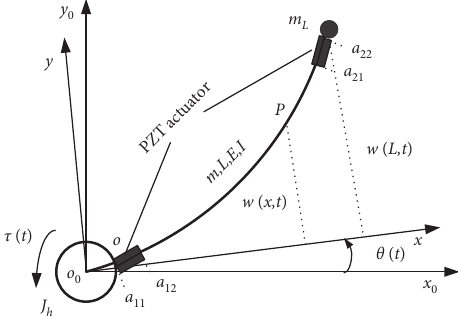
Figure 2: Model of the flexible manipulator with PZT